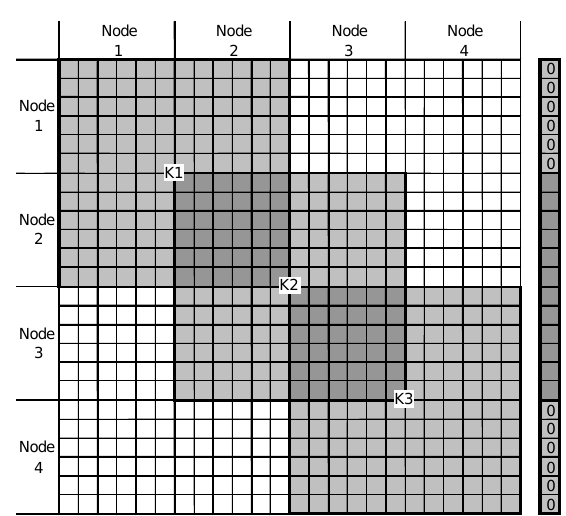
Fig. 4. Type of the global and the local stiffness matrices of FE (Fig. 3).